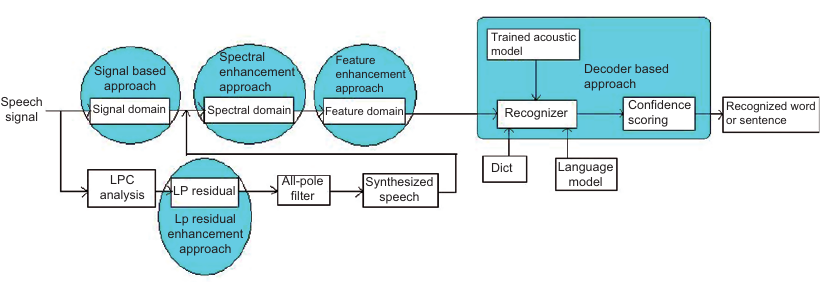
Figure 1 Block Diagram of a Speech Recognizer with Various Processing